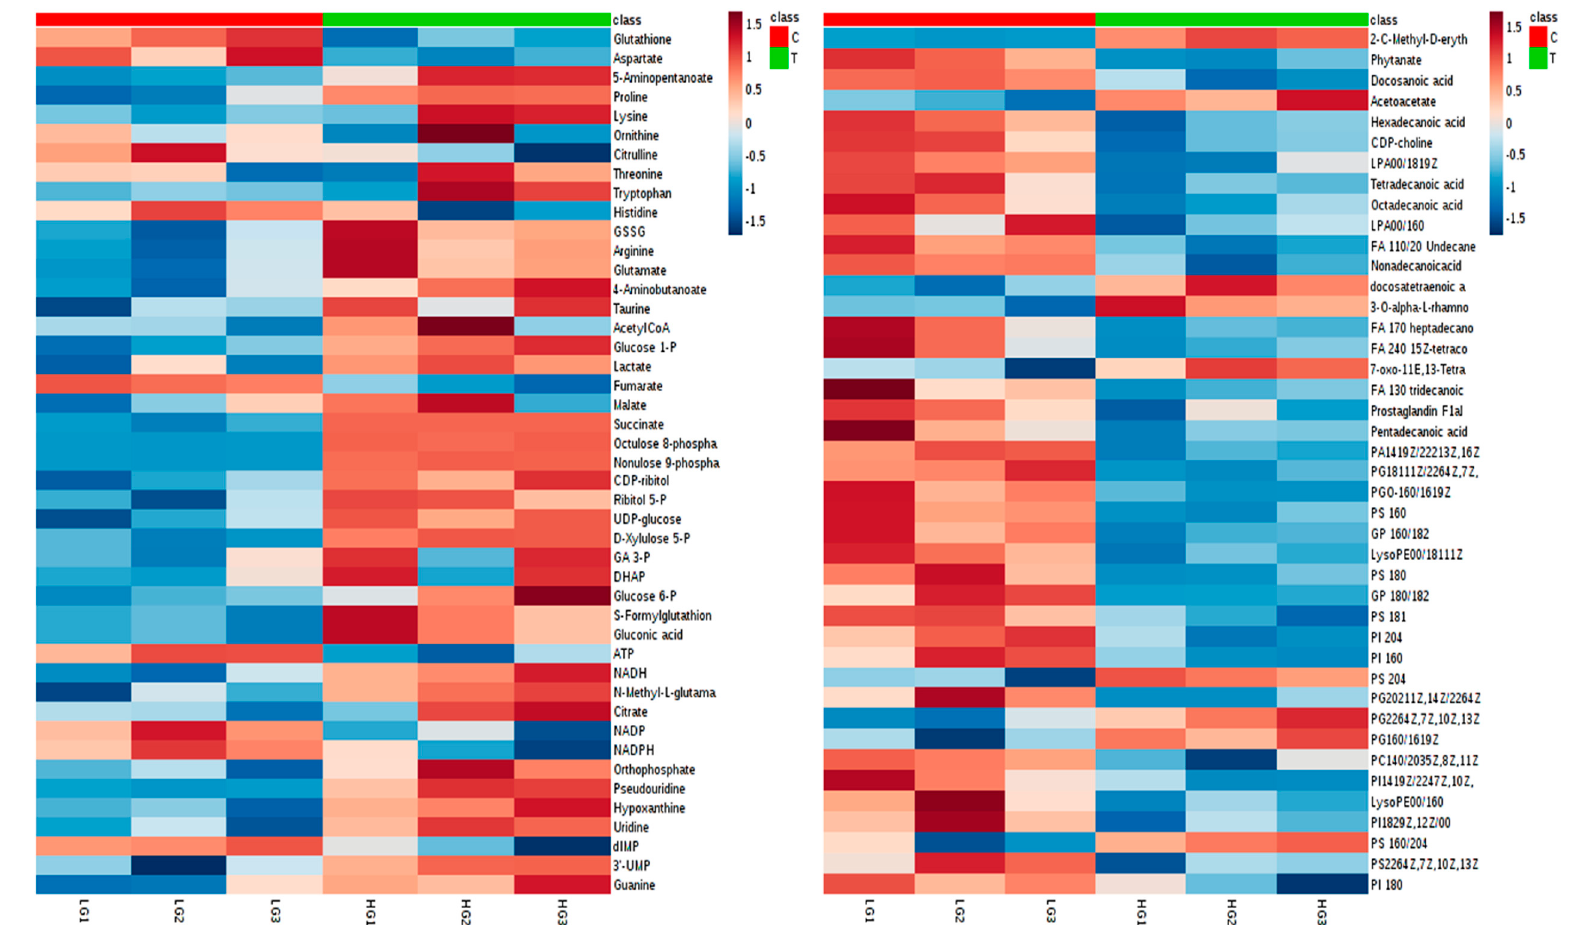
Figure 11. Heat map visualizing the significant metabolites impacted by high glucose (HG) comparing to normal glucose (LG) conditions. Row: represents the metabolite; Column: represents the samples group (red: normal glucose; green: high glucose); The color key specifies the metabolite intensity; lowest: dark blue; highest: dark red.